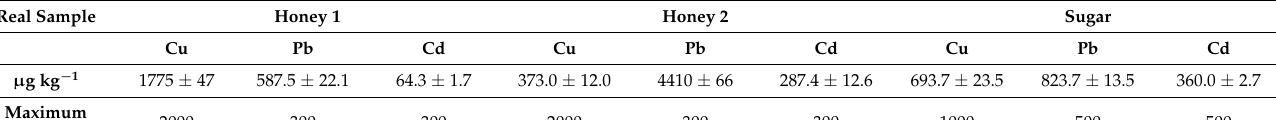
Figure 6. SWCSVs (baseline corrected), recorded at the HAp/GC electrode in 0.2 M KNO 3 (pH = 4), with corresponding calibration plots derived by subtracting the background current from the corresponding voltammograms of copper, lead, and cadmium.